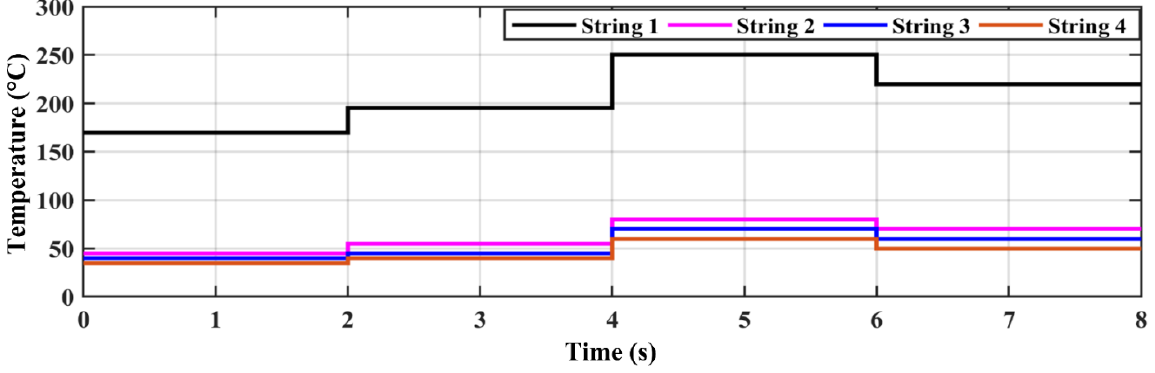
Figure 15. Change in hot-side temperature w.r.t time. Table 3. Case-2 results.